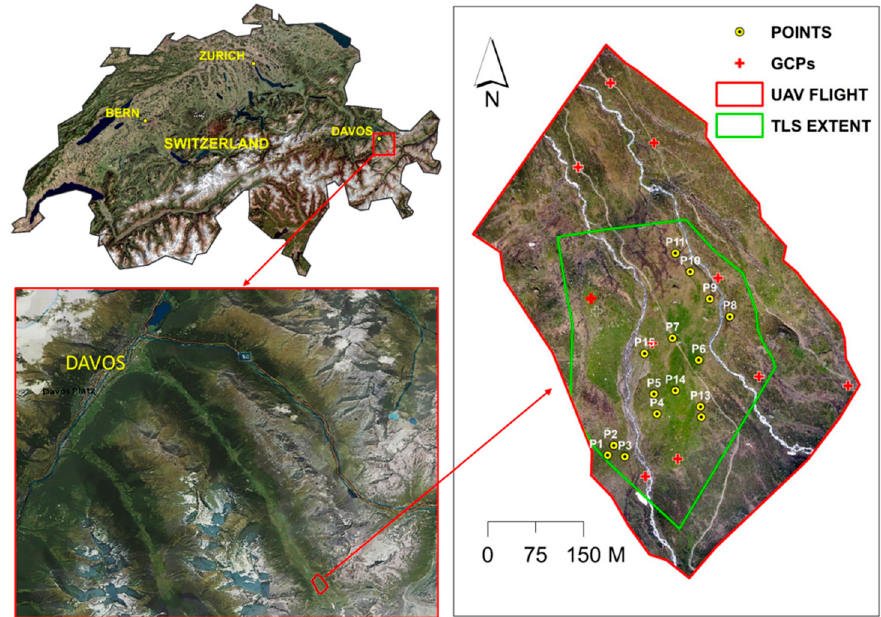
Figure 1. Location map of the study area (GCPs: ground control points; POINTS: 15 test points created over snow-covered areas during four of the time series for both UAS flights and TLS scans (i.e., 9–11 and 27 May 2016). These points were used to compare the UAS and TLS in terms of change in HS.